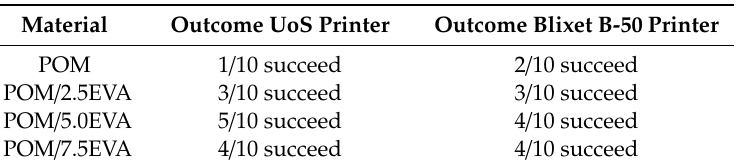
Table 10. Results of 3D printing attempts.